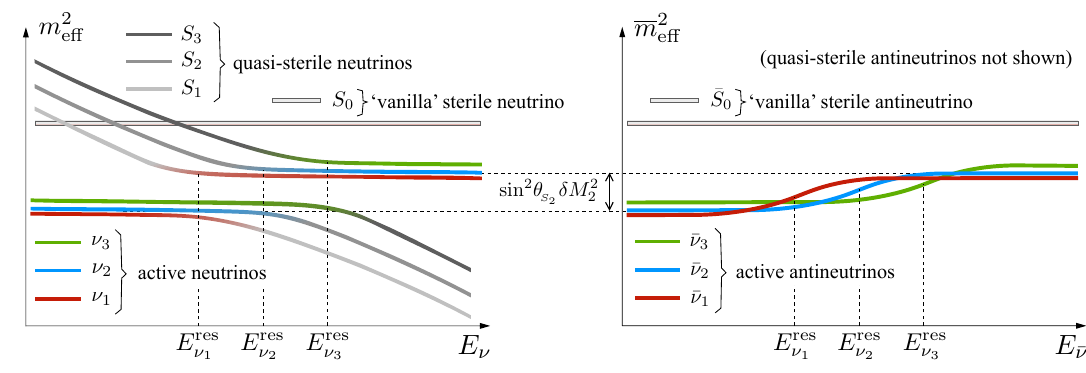
Figure 6 . [ For illustration purposes only — not to scale ] Effective mass-squared eigenvalues of neutrino propagation eigenstates (left panel) and antineutrino propagation eigenstates (right panel) as a function of (anti-)neutrino energy in the full model. The eigenstates’ flavor compositions are denoted by their color